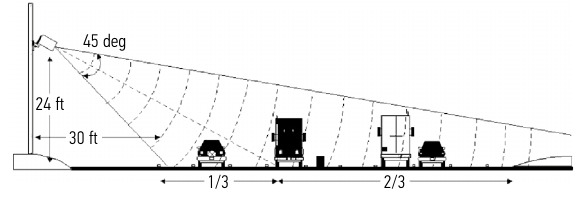
Fig. 1. Analyzed roads: SP175 and SP30